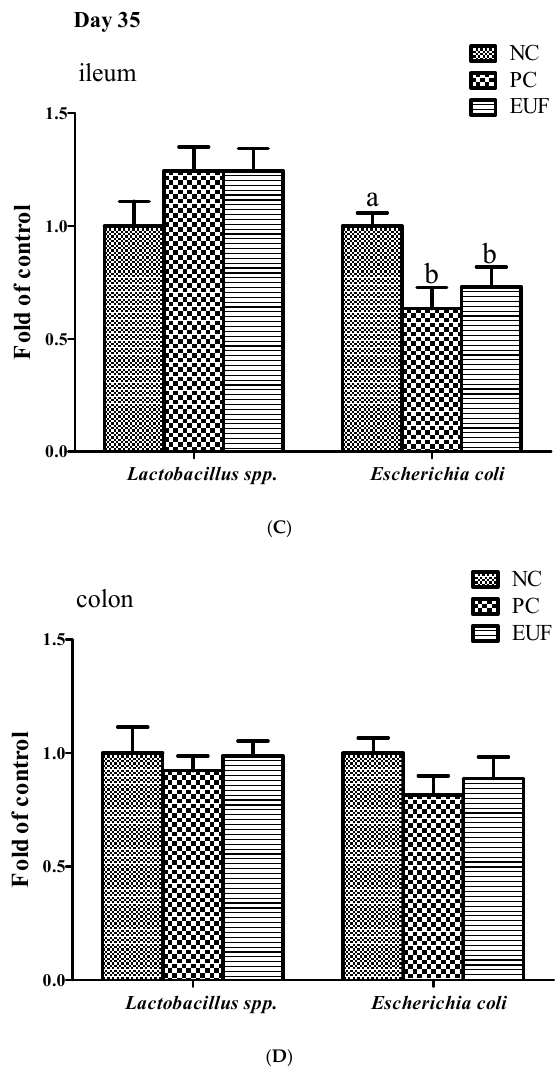
Figure 3. Relative abundance of Lactobacillus spp. and Escherichia coli in the ileum ( A , B ) and colon ( C , D ) of piglets. NC = negative control, low-protein basal diet no antibiotics included; PC = positive control, low-protein basal diet + antibiotics (75 mg/kg quinocetone, 20 mg/kg virginomycin and 50 mg/kg aureomycin); EUF = Eucommia ulmoides flavones, low-protein basal diet + 0.01% EUF. Values are the mean ± SEM, n = 8 per treatment group. a,b Values with different letters are significantly different ( p < 0.05).